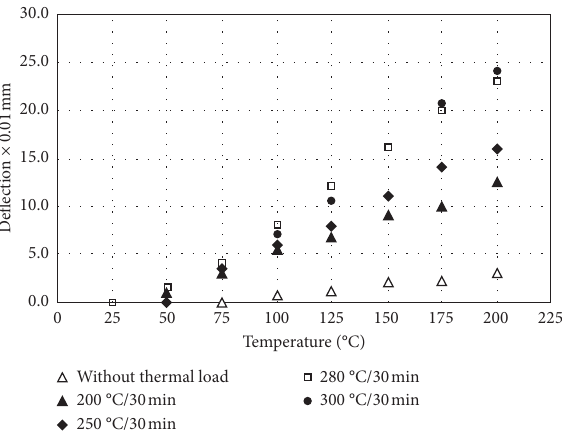
Figure 12: Determination of shape deflection (0.01mm) plot according to temperature.